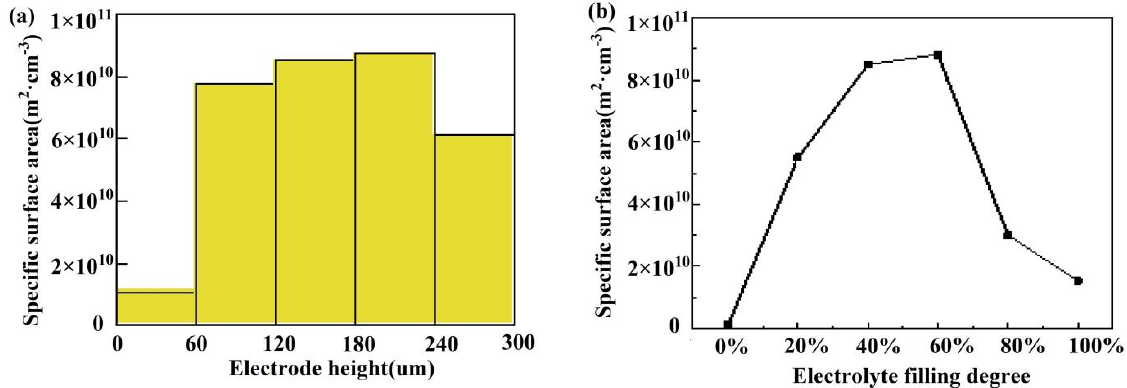
Figure 6. Specific surface area of different partitions ( a ) and triple ‐ phase interface ( b ).